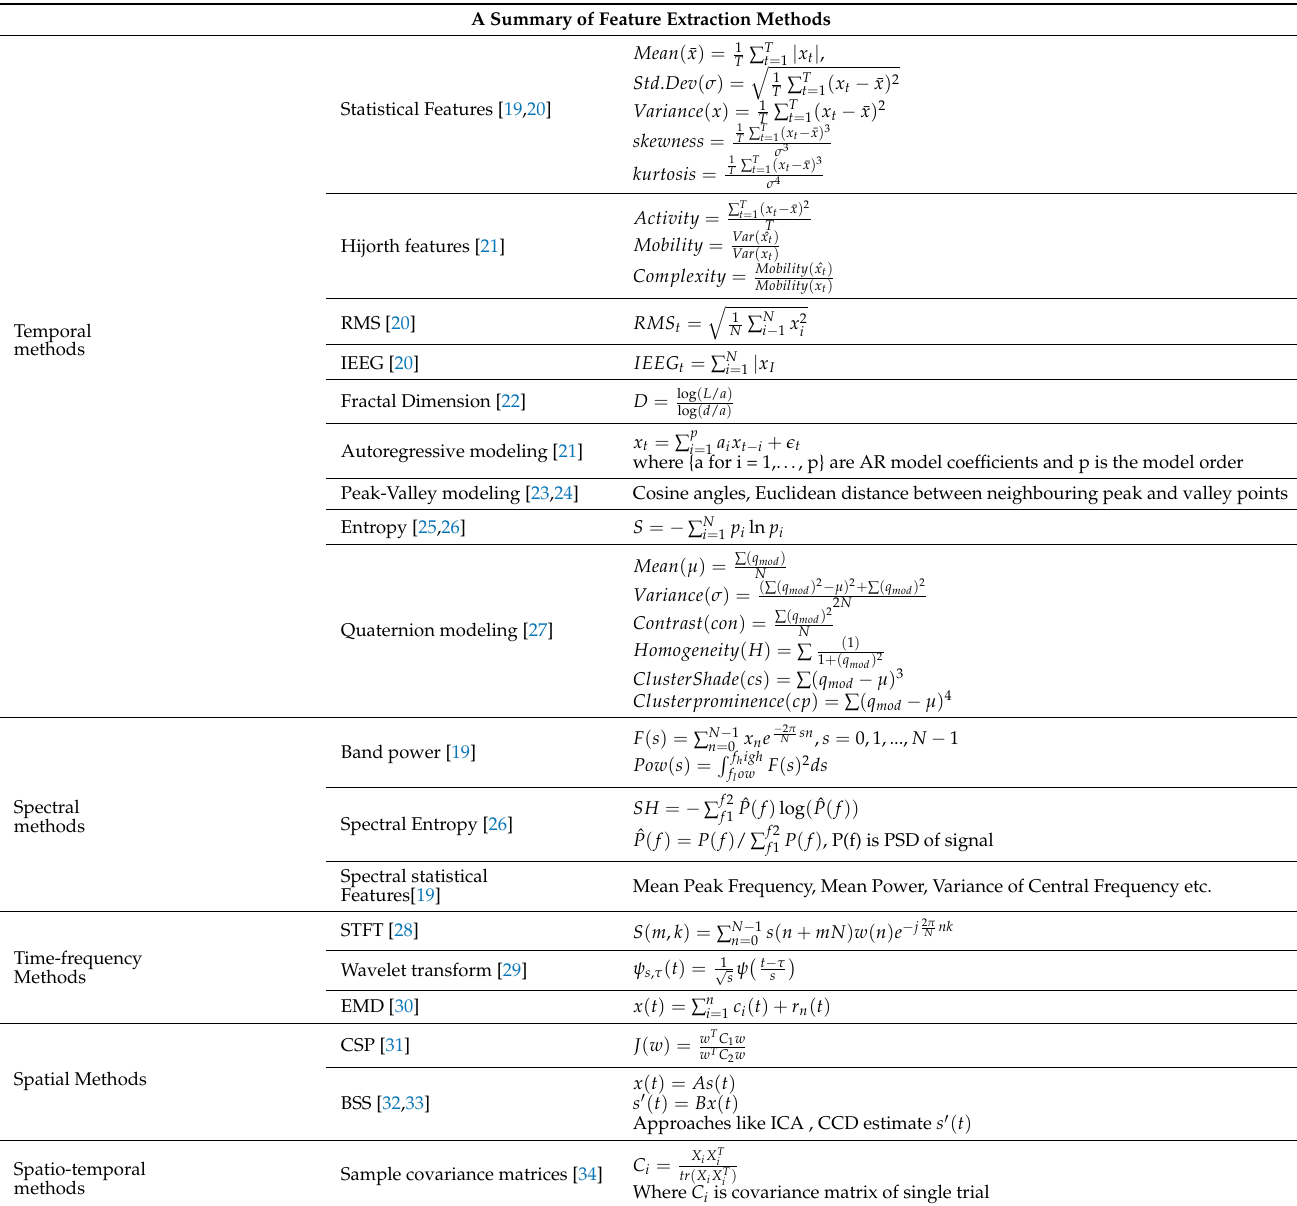
Table 1. This table provides a summary of the feature extraction methods. A Summary of Feature Extraction